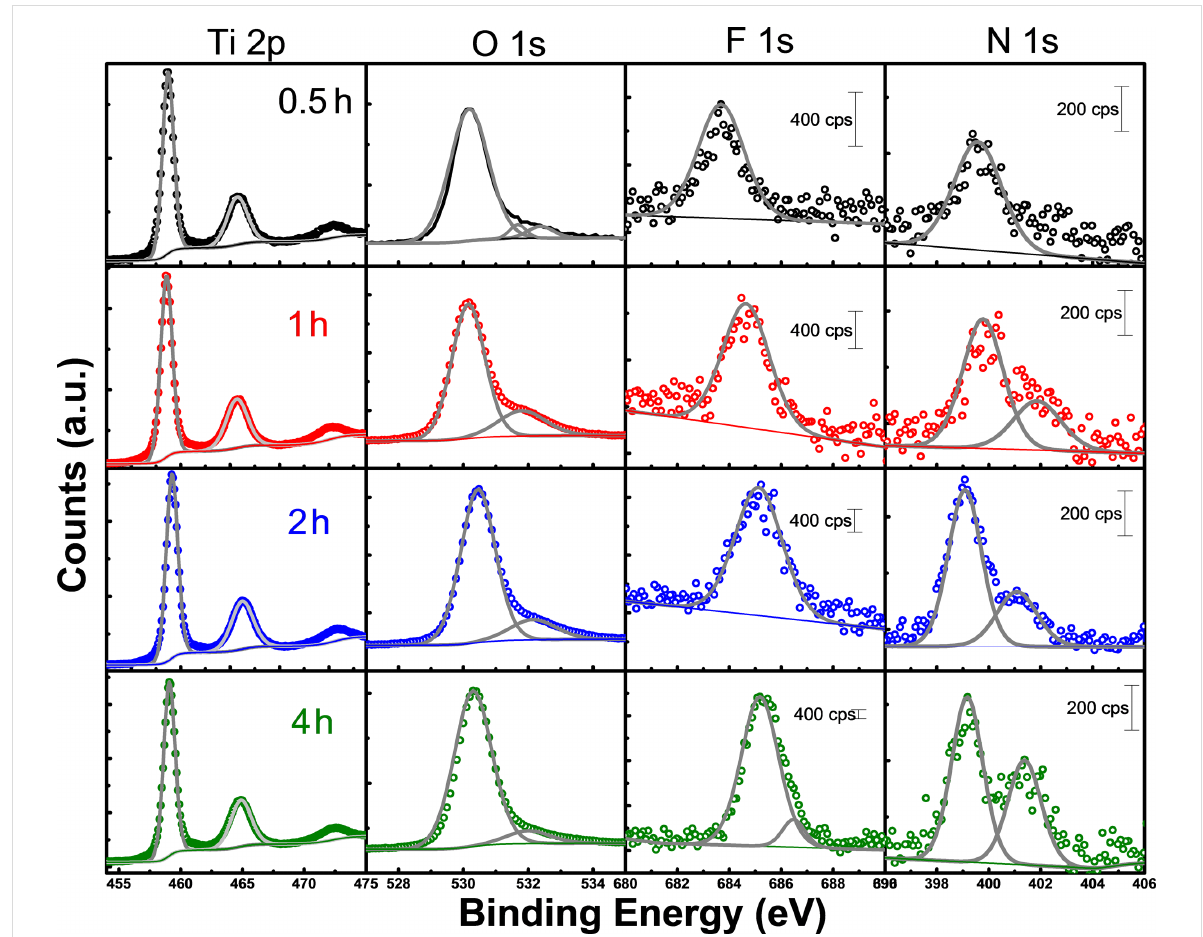
Figure 2: High-resolution XPS spectra for Ti 2p, O 1s, F 1s and N 1s obtained for the TNTs after each t a .